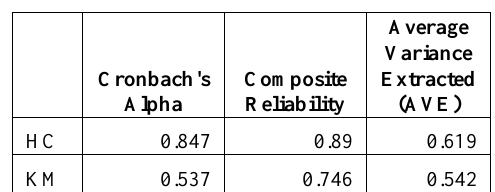
Table 8: Higher-Order Reliability and